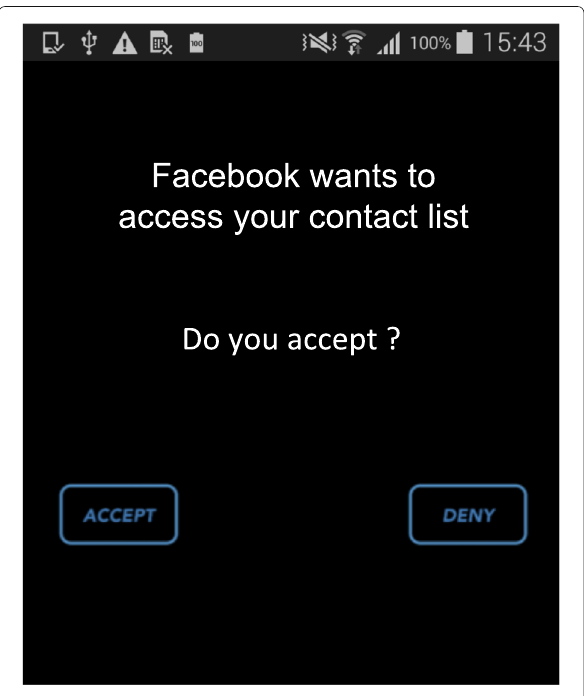
Fig. 6 Interactions of Kapuer during the learning phase